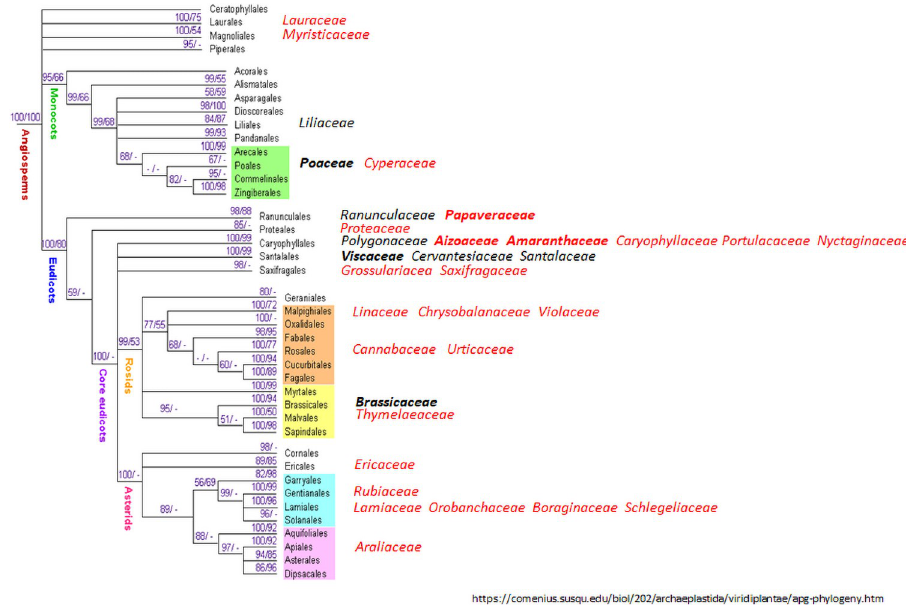
Fig 2. Phylogeny of angiosperms showing plant families with species having thionins. Black, families containing previously known thionins; red, families with newly found thionins from the 1Kb project. Bold, families containing many thionins. Phylogeny modified from https://comenius.susqu.edu/biol/202/archaeplastida/viridiplantae/apg- phylogeny.htm. https://doi.org/10.1371/journal.pone.0254549.g002 with all four disulfide bonds. We tested the antimicrobial activity against Fusarium oxysporum and Botrytis cinerea (Figs 6 and 7). The IC was approximately 1 μ g/ml for F . oxysporum and 50 6 μ g/ml for B . cinerea after 48 hours. Microscopic inspection of the hyphae revealed no mor- phological alterations such as hyperbranching or swelling of hyphal tips (Fig 7). The activity